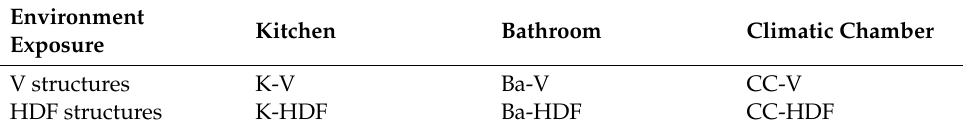
Table 2. The samples identification .